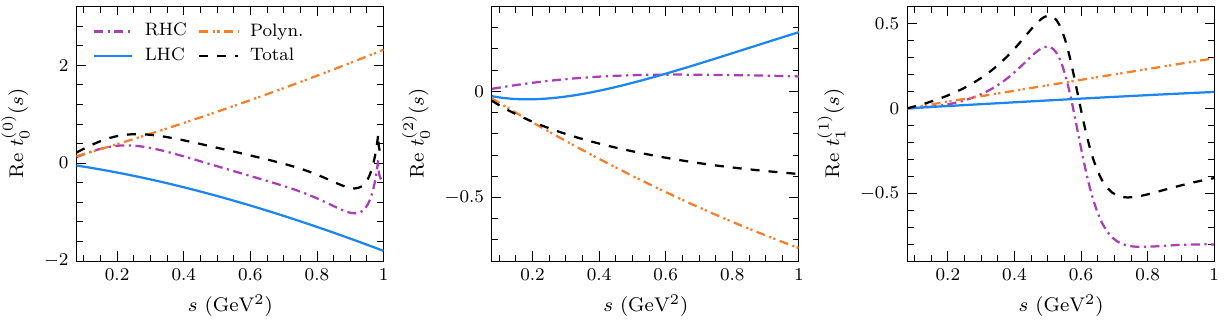
Fig. 4 Contributions to the total partial-wave amplitude using setup A as described above (black dashed line): RHC integral (purple dash-dotted line), LHC integral (blue solid line), and polynomial term (orange dash-double-dotted line). Only the S - and P -waves are